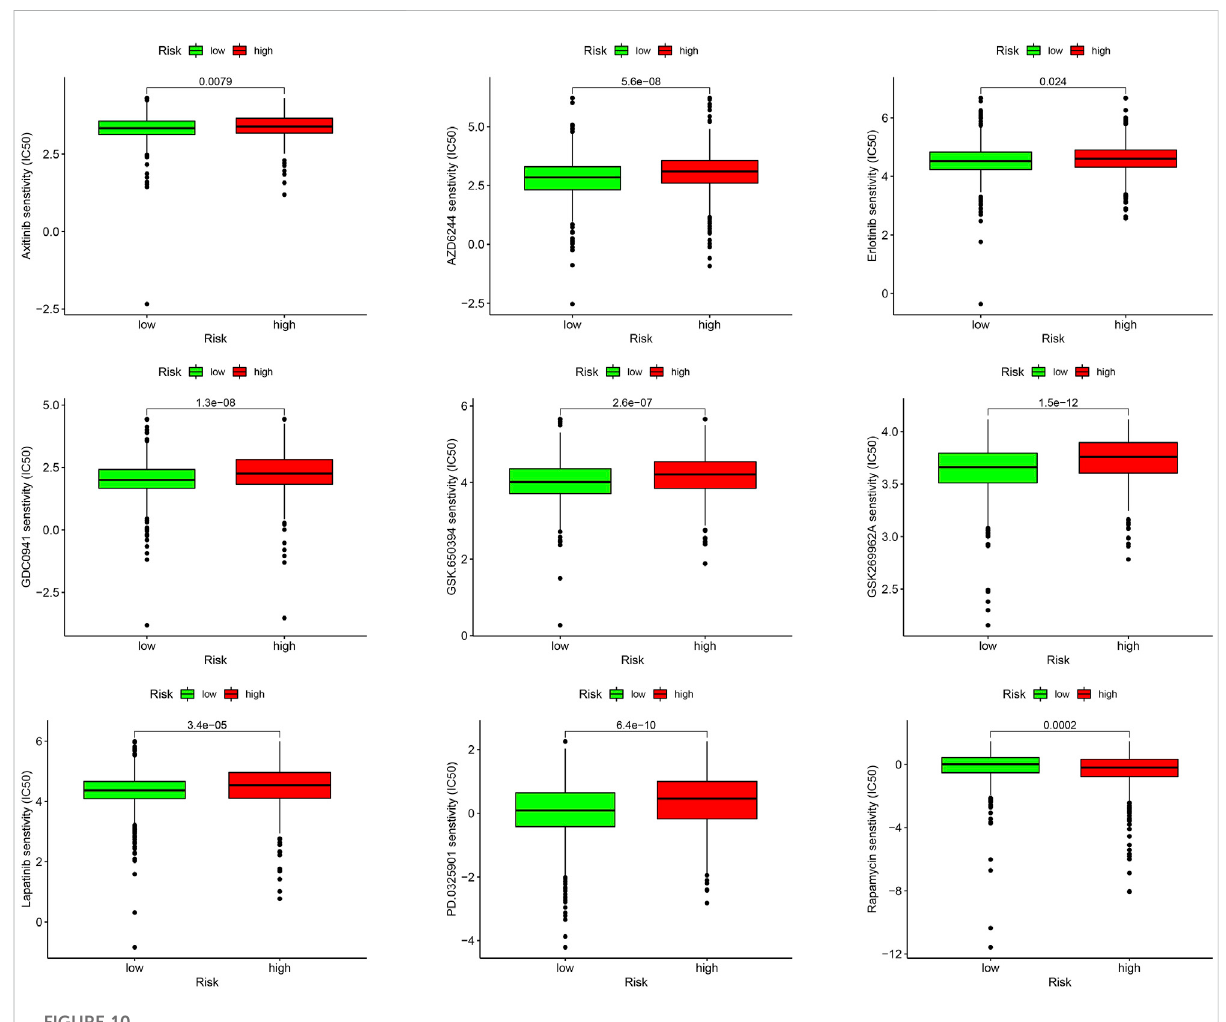
FIGURE 10 Drug sensitivity analysis between high- and low-risk